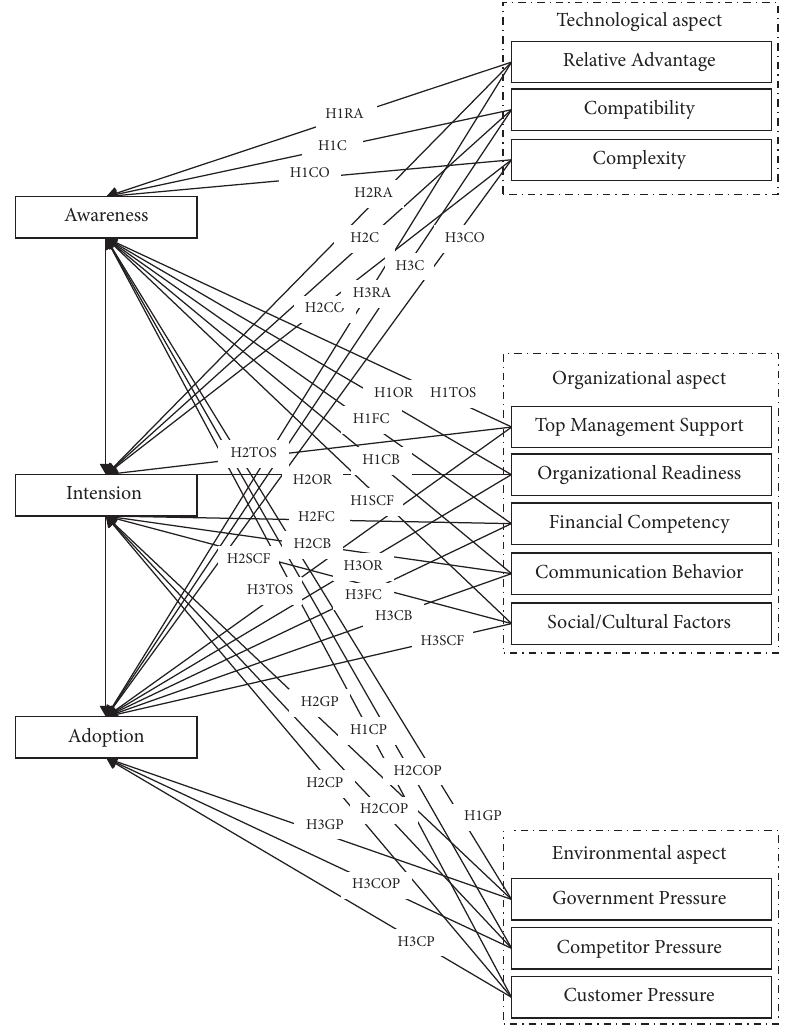
Figure 2: Hypothetical structural equation model. Table 2: Hypothesis about the effect of technological aspect in public and private sectors across adoption stages. Drivers Coding Null hypothesis